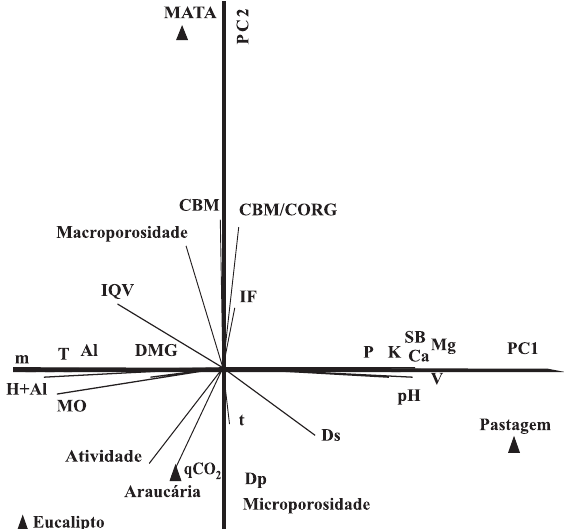
Figura 3. Análise de componentes principais das médias dos atributos físicos e microbianos em conjunto com os valores dos atributos químicos do solo e visuais dos diferentes ecossistemas estudados ( ). Físicos: IF (índice de floculação), Ds (densidade do solo), Dp (densidade de partículas), DMG (diâmetro médio geométrico). Microbianos: Atividade (atividade microbiana ou (quociente metabólico), respiração basal), qCO 2 CBM (C da biomassa microbiana), CBM/CORG (quociente entre C da biomassa microbiana e C orgânico do solo). Químicos: MO (matéria orgânica), SB (soma de bases), V (saturação por bases), m (saturação por alumínio), H + Al, T (CTC a pH 7,0), t (CTC efetiva). IQV: índice de qualidade